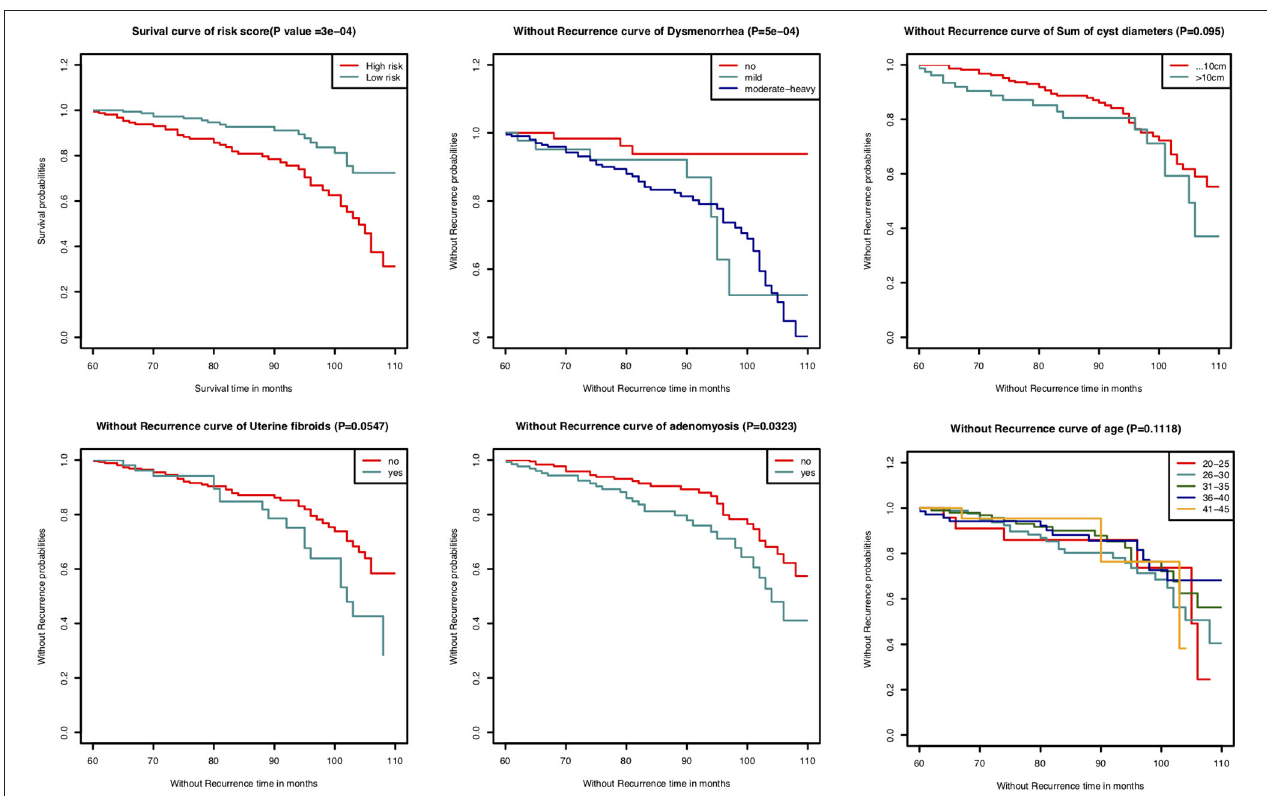
FIGURE 4 | Kaplan-Meier survival curves of derivation